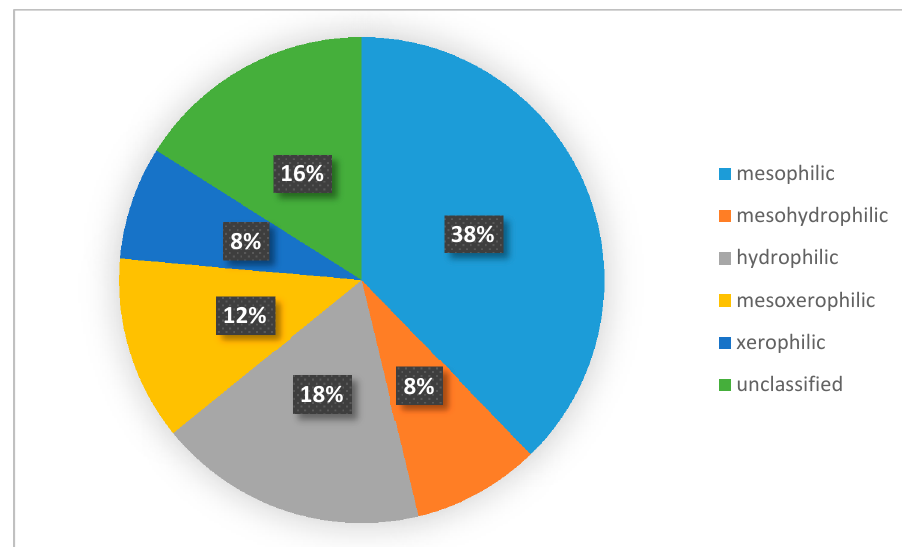
Figure 10. Per cent of Carabidae species with a different hygropreference. Diagram was made based on selected publications, including data about the ecological characteristic of Carabidae communities inhabiting the investigated plants.